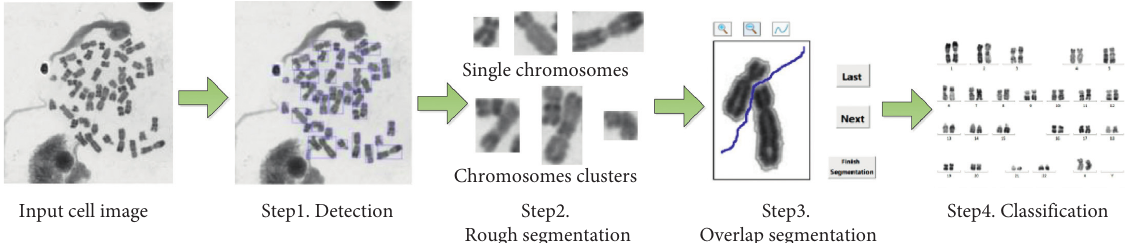
Figure 2: General steps of former automatic chromosome karyotyping method: (1) detecting chromosome regions from input cell image, (2) rough segmentation to generate single chromosomes and chromosomes clusters, (3) overlap segmentation on chromosome clusters to achieve individual chromosomes, and (4) apply classifiers on individual chromosomes to perform